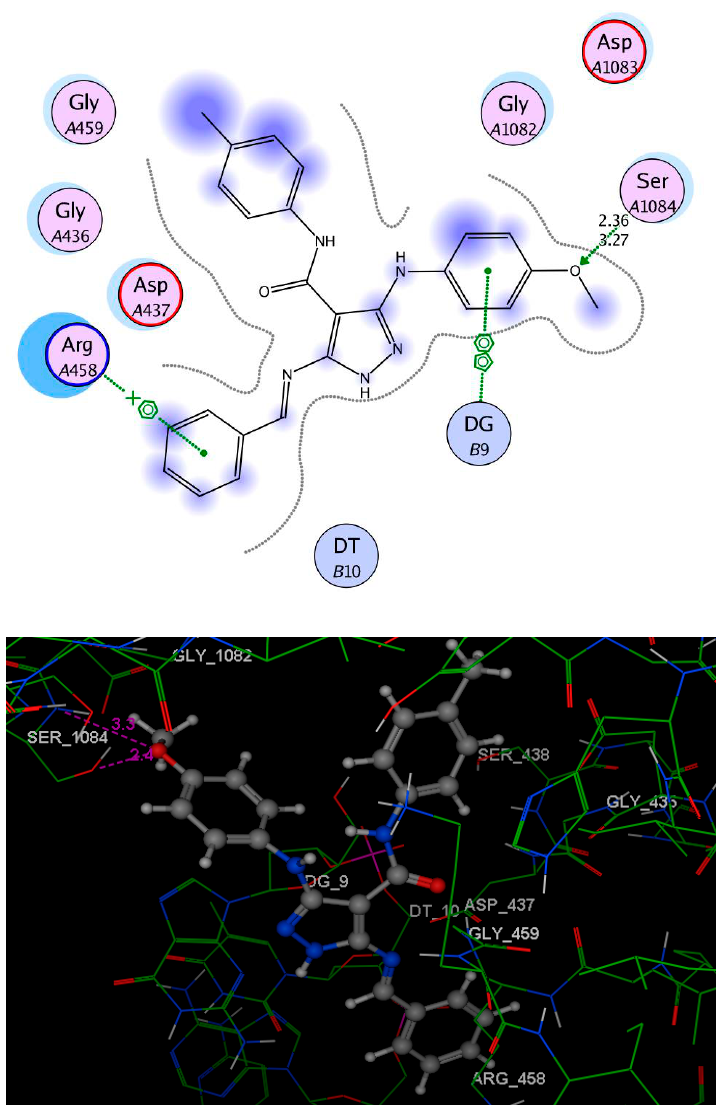
Figure 4. 2D and 3D interaction diagrams of compound 18 with Staphylococcus aureus DNA gyrase (PDB code: 2XCT) (hydrogen bonds are illustrated as arrows, C atoms are colored gray, N blue, and O red).